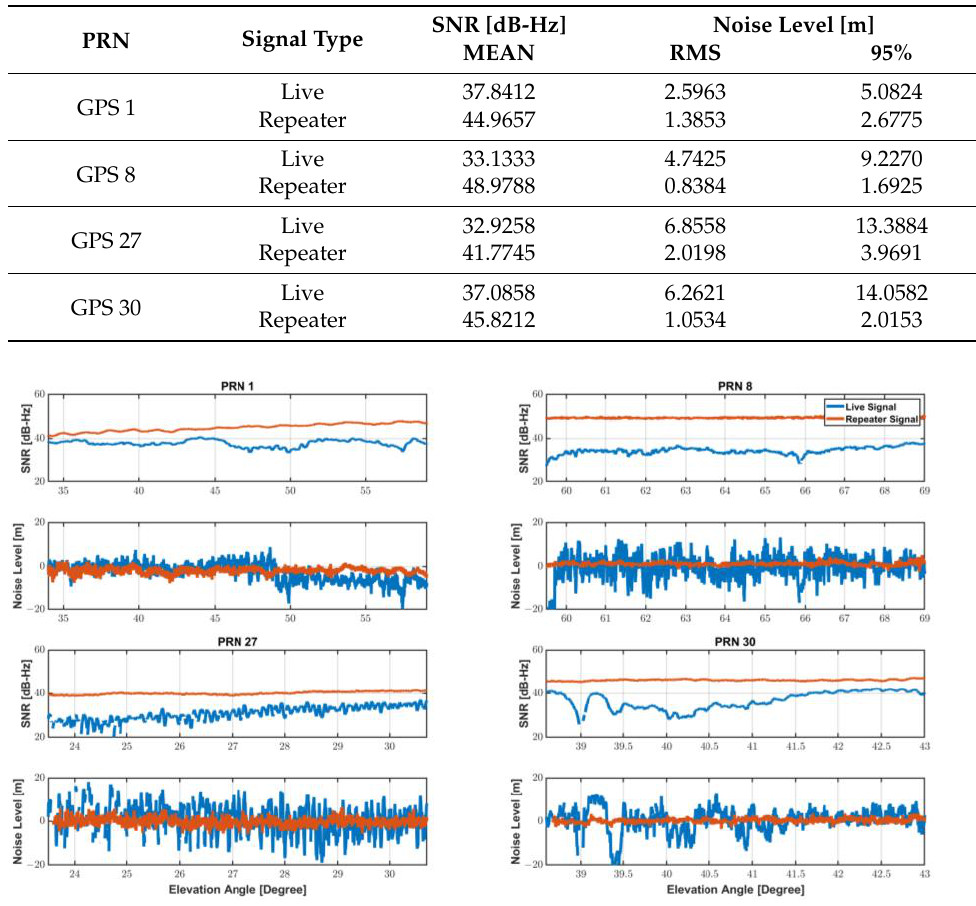
Figure 2. SNR and Noise-level of Live and Re-radiated signal. The smartphone observed the signals passing through the GNSS repeater with an SNR value of 40 dB-Hz or higher. In contrast, the SNR of the PRN 8 was observed around 30 dB-Hz when a smartphone receiving live signal and did not exceed 40 dB-Hz despite a high elevation angle of 60 ◦ or more. Signal SNR observed by a commercial GNSS receiver generally increases as the elevation angle increases. The clear relationship between elevation and SNR, however, is not found in smartphones equipped with low-cost GNSS antenna. To make matters worse, as can be seen from PRNs 27 and 30, SNR and noise fluctuations due to multipath were significantly severe to smartphone